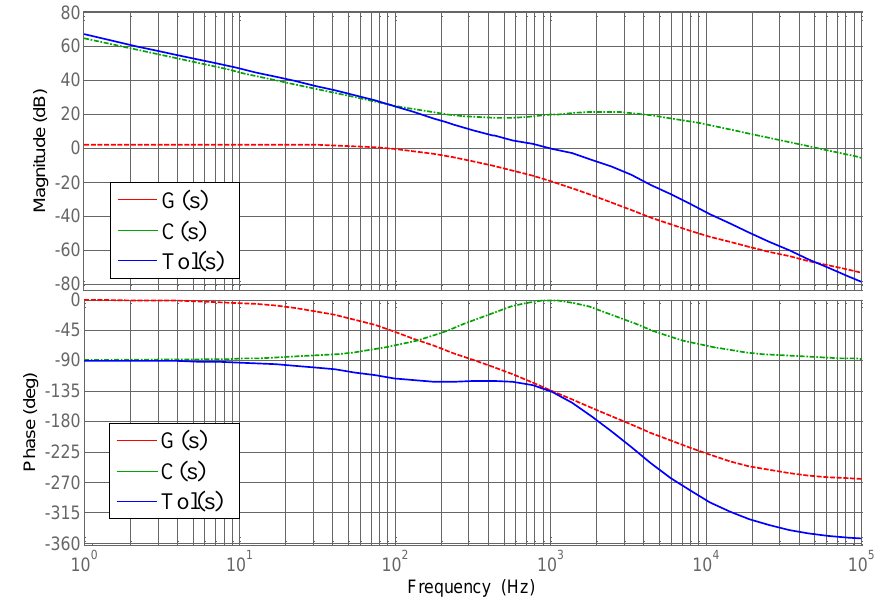
Figure 11. Bode plots of plant, controller and loop gain.